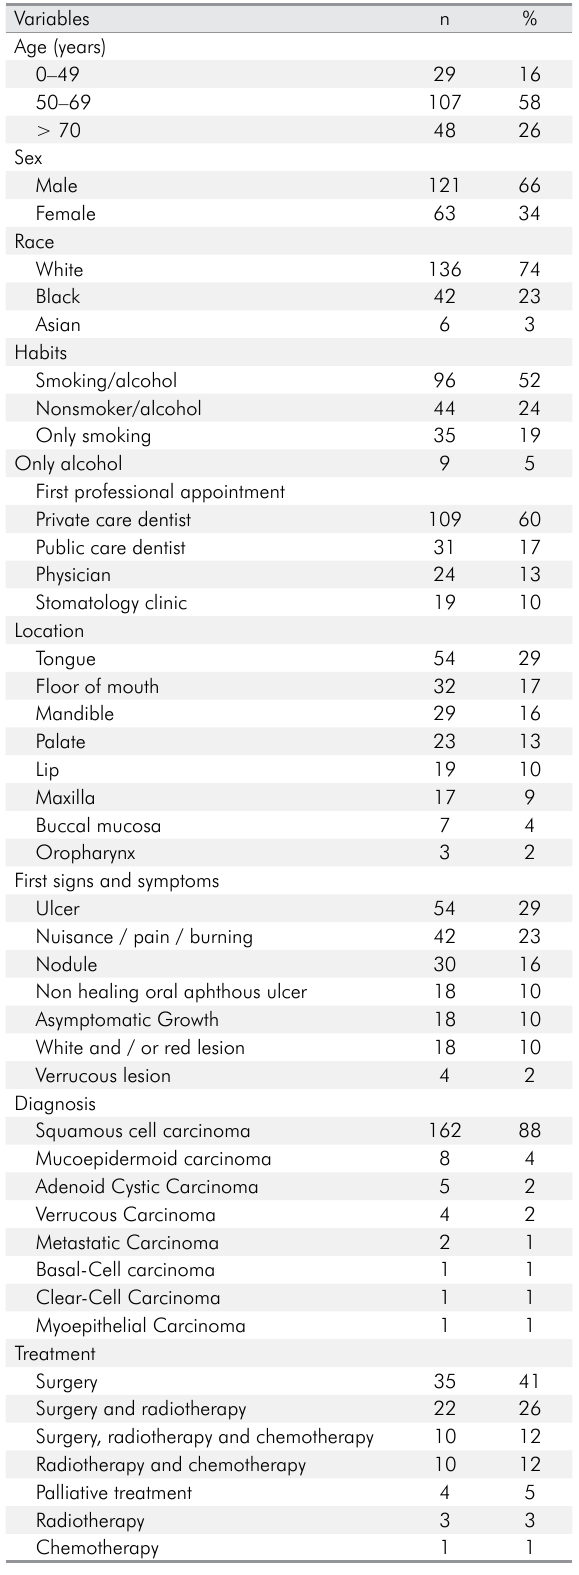
Table 1. Distribution of patients according to epidemiological data and medical